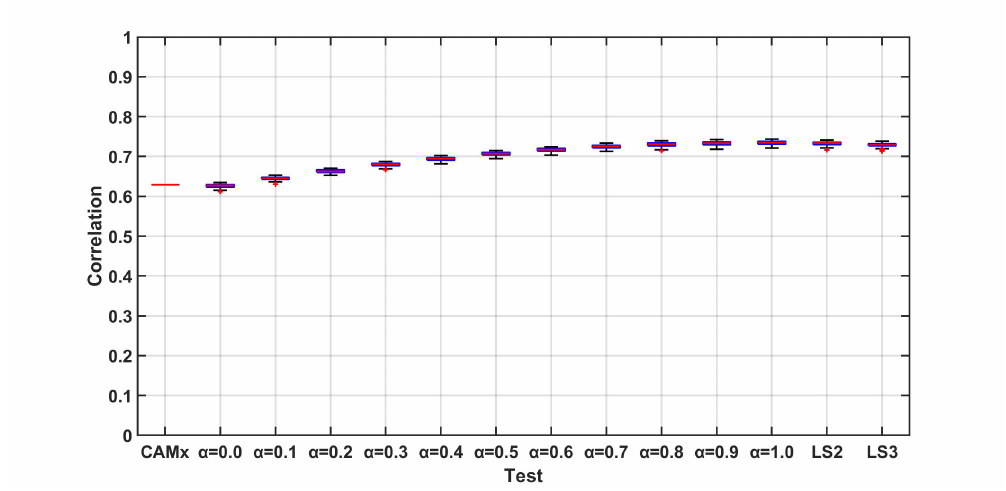
Figure 4. Correlation for the one-step-forward forecast.